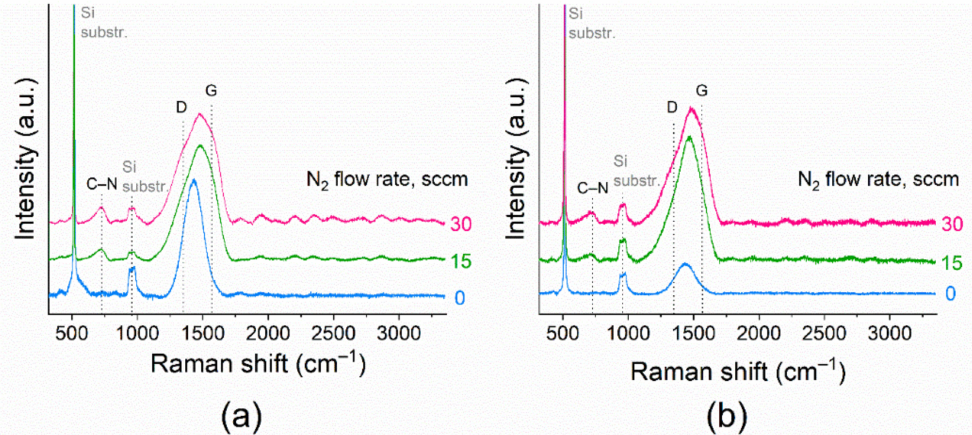
Figure 6. Raman spectra of SiC x N y films, deposited at ( a ) T dep = 25 and ( b ) 300 ◦ C (series A and C).